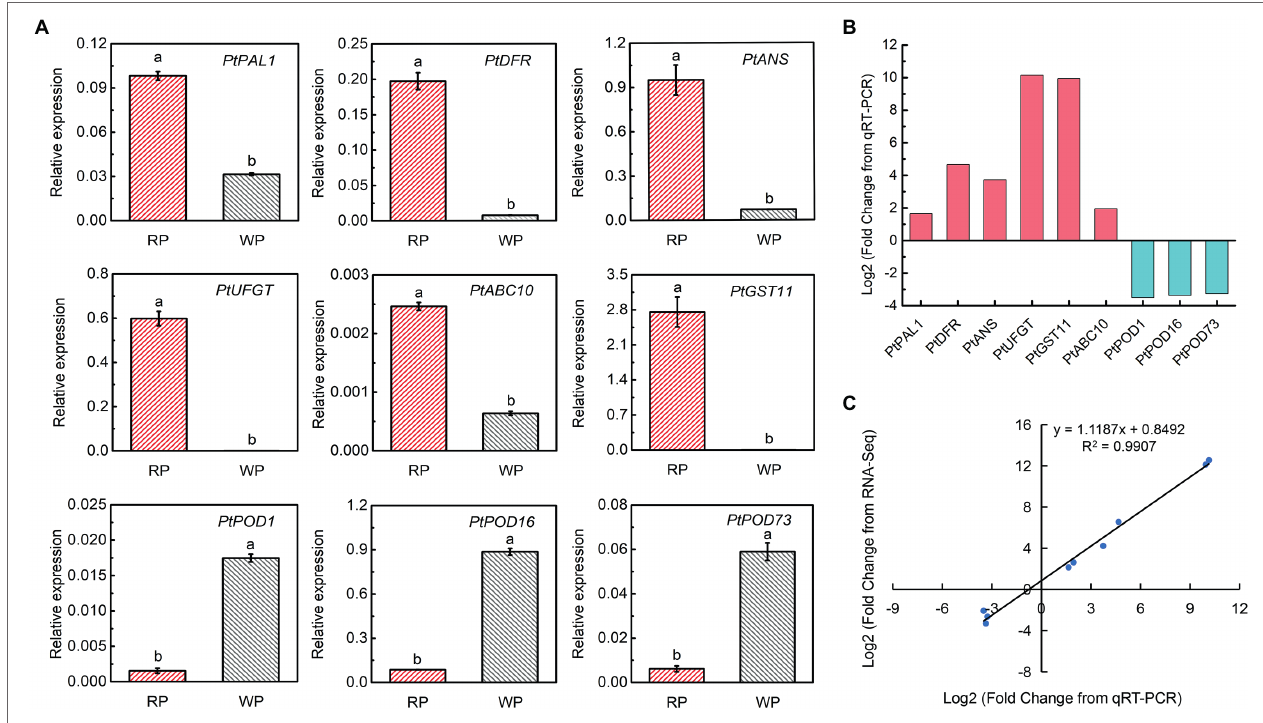
FIGURE 6 | Expression analysis of the key significant DEGs related to the anthocyanin accumulation. (A) Gene expression of candidate key significant DEGs involved in anthocyanin synthesis, transport, and degradation. Tukey’s test significant at p < 0.05 indicated by a and b. (B) Log 2 Fold Change of differentially expressed anthocyanin-related genes between WP and RP from real-time PCR. (C) Correlation analysis based on RNA-seq data and real-time